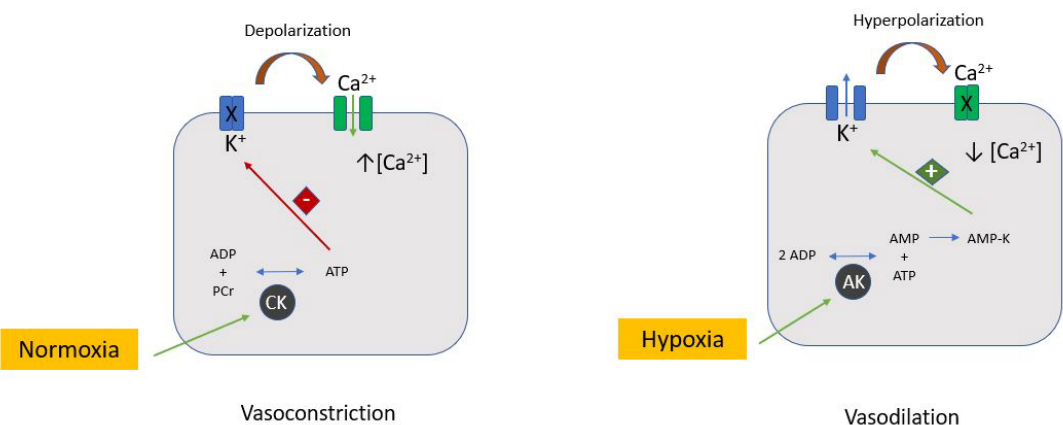
Figure 1. K-ATP channels and vascular tone. ATP-sensitive potassium (KATP) channels are cell membrane metabolic sensors that affect membrane excitability depending on the cellular energetic status. In normal conditions, the CK pathway is much more expressed than the AK one. A sufficient intracellular ATP concentration keeps the KATP channel closed. Hypoxia determines the activation of the AK pathway with an increase of AMP-K which opens the KATP channels. A K + outflow causes hyperpolarization and, consequently, Ca 2+ channel closing. The low intracellular Ca 2+ concentration causes vasodilation. AK: Adenylate kinase ADP: Adenosine diphosphate; AMP-K: AMP-activated protein kinase; CK: Creatine kinase; PCr: Phosphocreatine. Voltage-gated sodium (Nav) channels lead to a late and peak Na + current which brings cell depolarization. Coronary Nav channels are implicated in endothelial-dependent vasodilation via